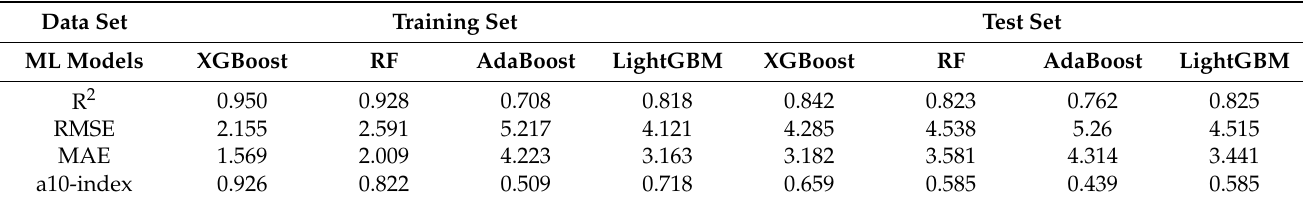
Table 3. Performance of ML